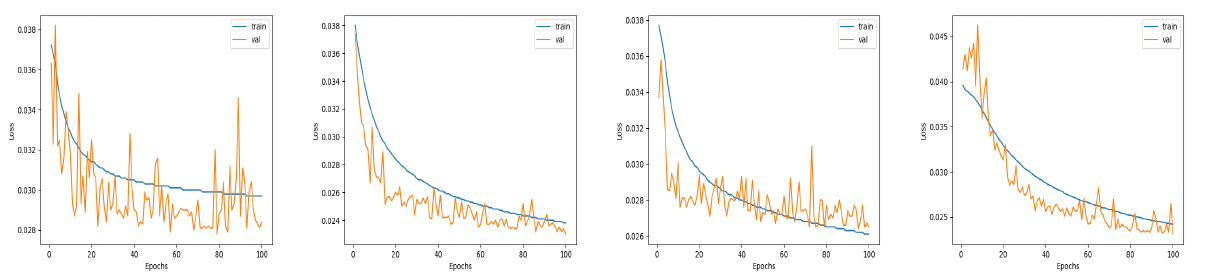
Figure 6. Training and validation loss curves for the different methods on the ISPRS Ikonos dataset. From left to right: only A , only Φ , A & Φ , Proposed